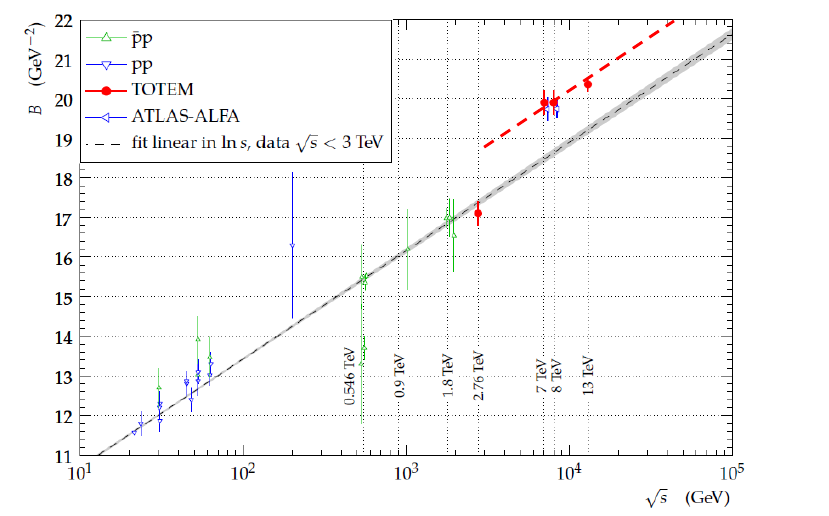
Figure 5. Excitation function of the slope parameter B in elastic proton-proton scattering. The TOTEM data at 2.76, 7, 8 and 13 TeV suggest the opening of a new channel between √ s = 2.76 and 7 TeV, as noted in ref. [1] and indicated qualitatively by the red dashed line.